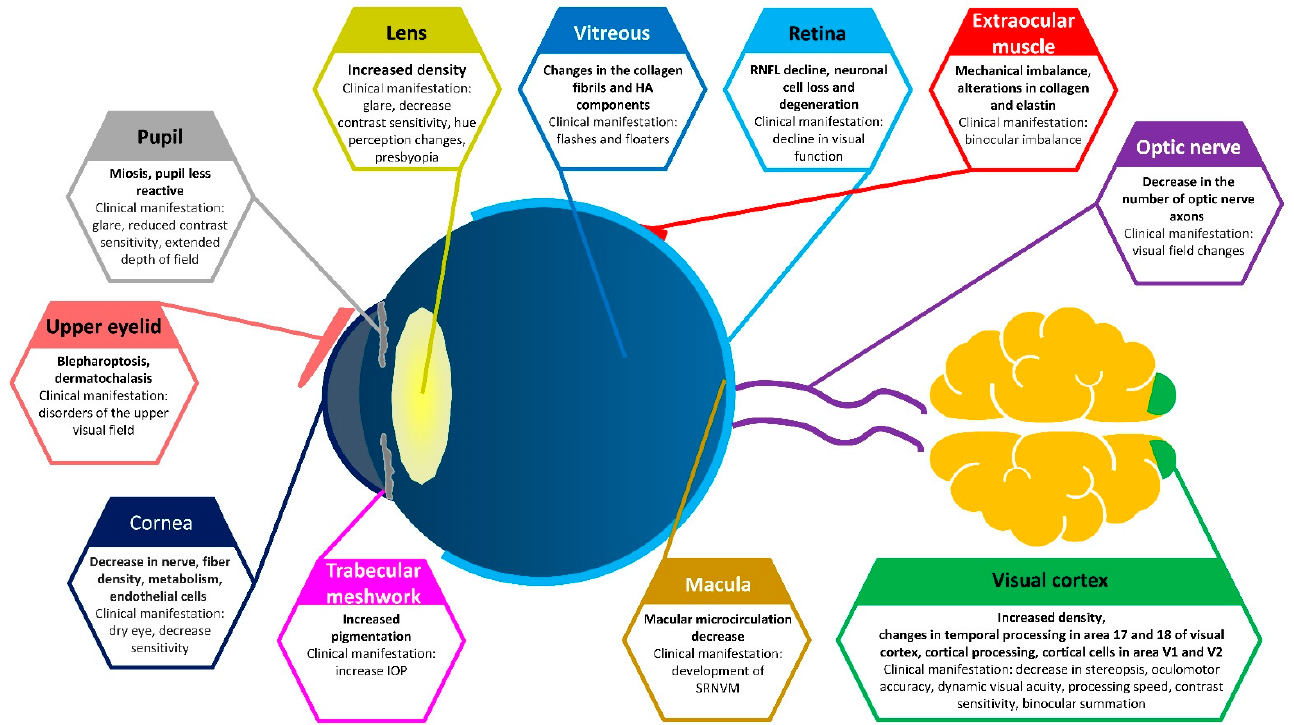
Figure 1. Primary physiological changes during aging and their clinical manifestations. SRNVM: subretinal neovascular membrane; IOP: intraocular pressure; HA: hyaluronic acid.